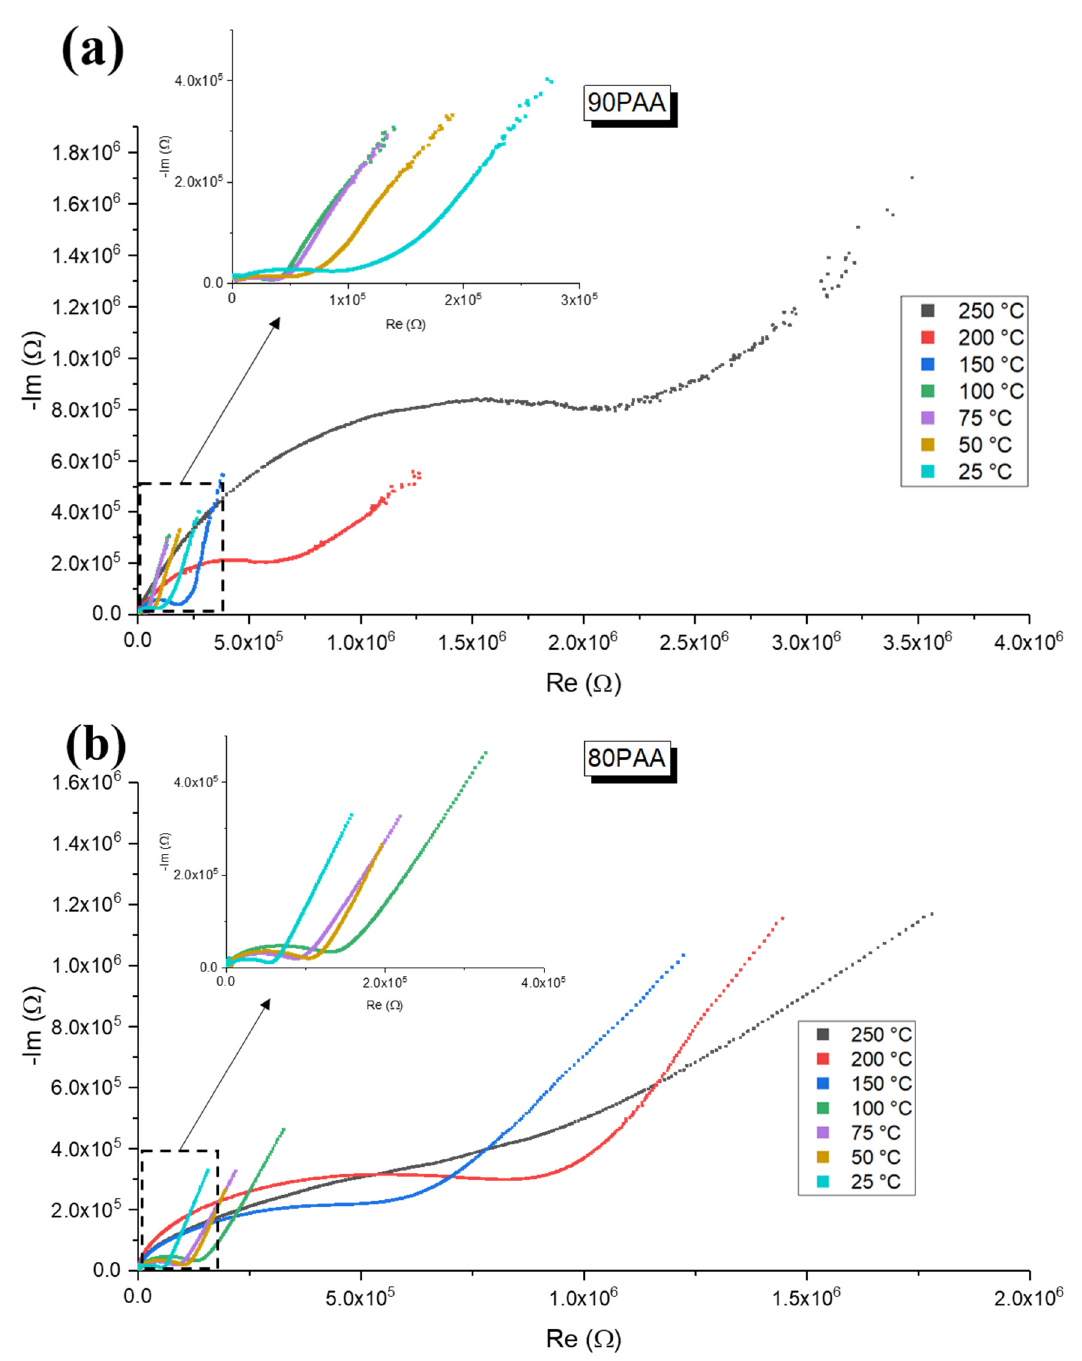
Figure 10. Electrical response of the samples to temperature variation: ( a ) 10 wt.% binder content sample; ( b ) 20 wt.% binder content sample.